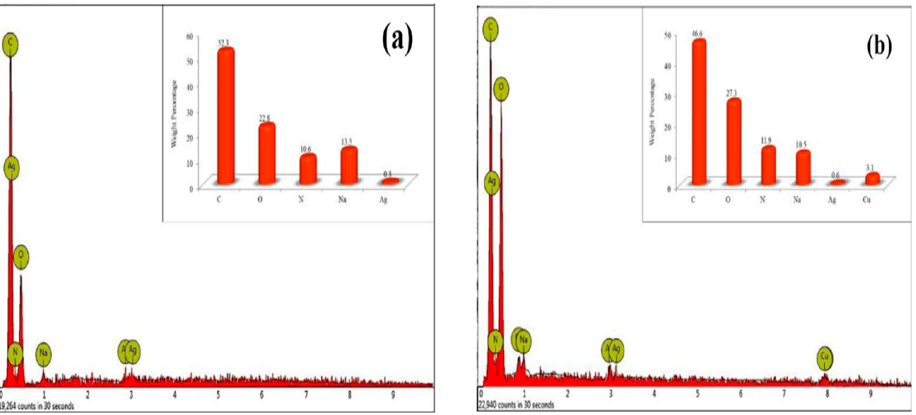
Figure 12. EDX spectra of NPGESNC-AcA ( a ) before Cu 2+ adsorption, and ( b ) after Cu 2+ adsorption (Reprinted from Ref. [121], Copyright (2022), with permission from Elsevier).